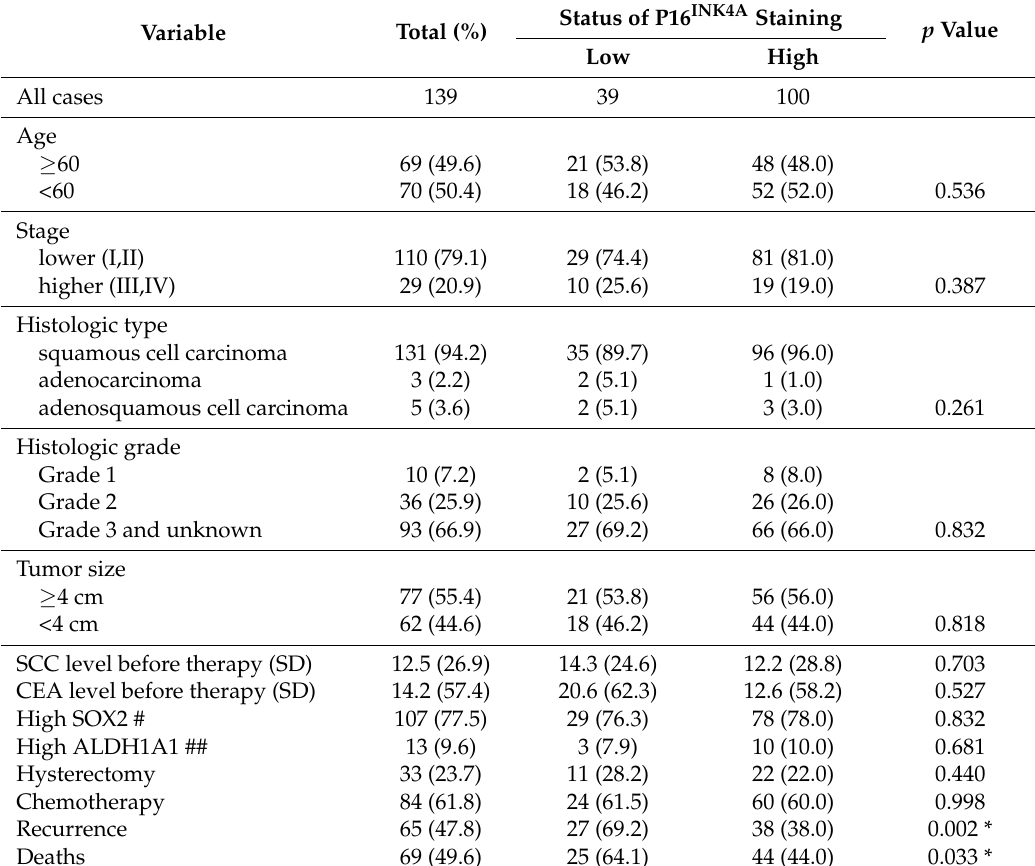
Table 1. Patient